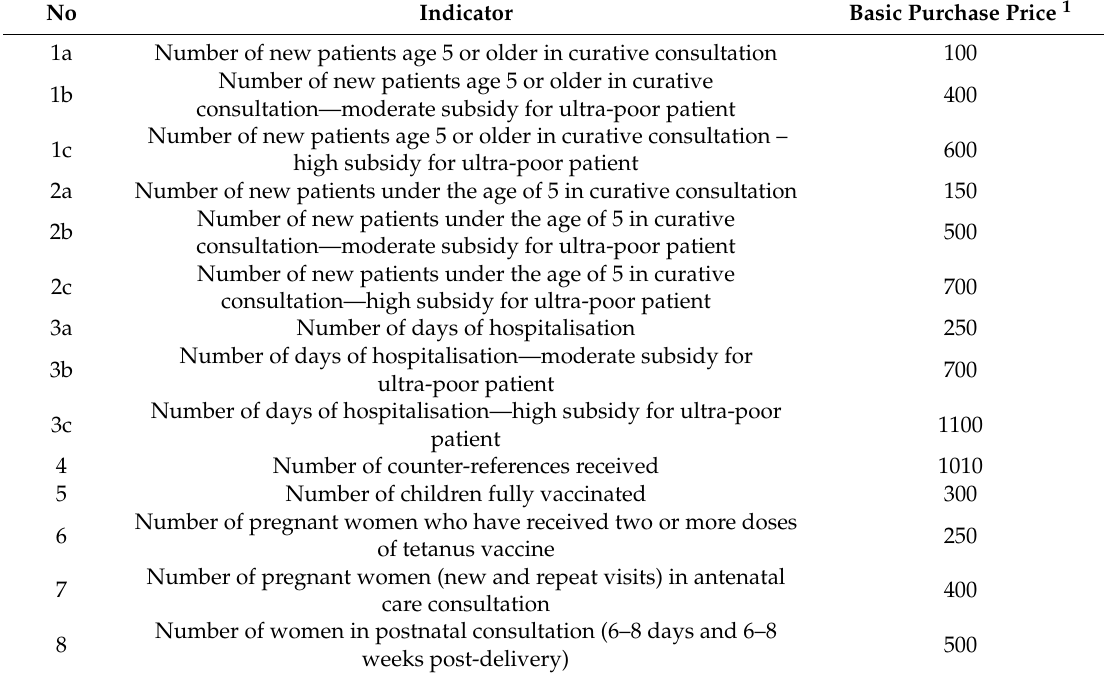
Table A1. List of Quantity Indicators Included in PBF design (Primary Health Care